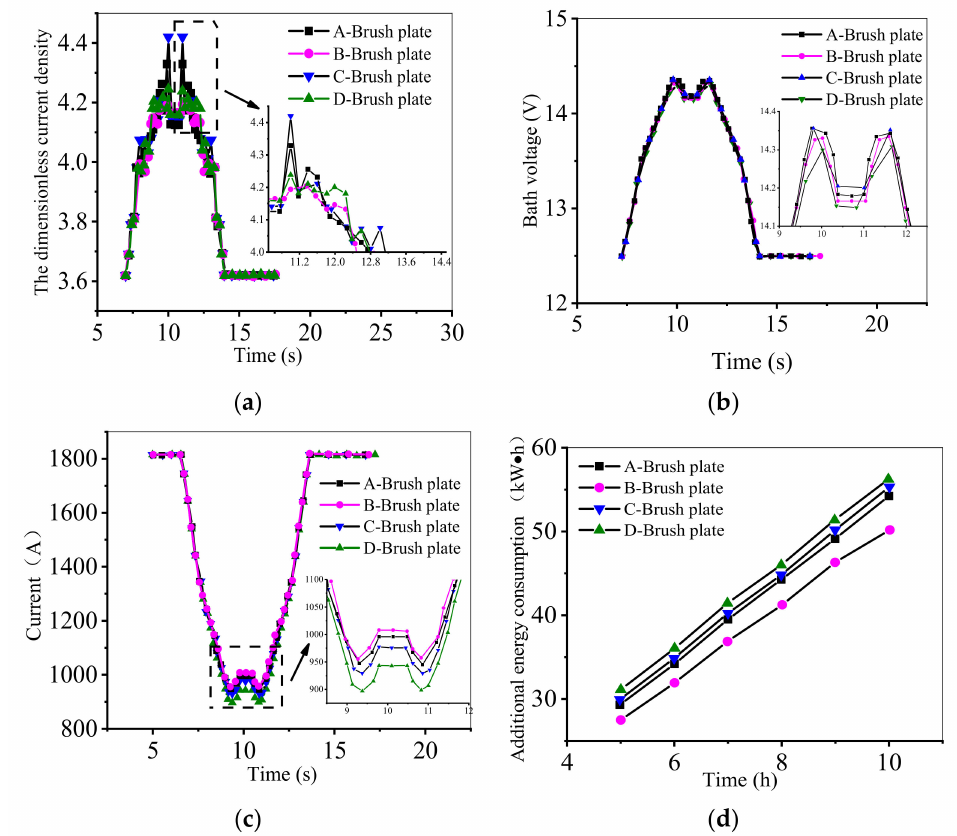
Figure 15. The variation of parameters with time. ( a ) The dimensionless current density; ( b ) Bath voltage; ( c ) Current; ( d ) Additional energy